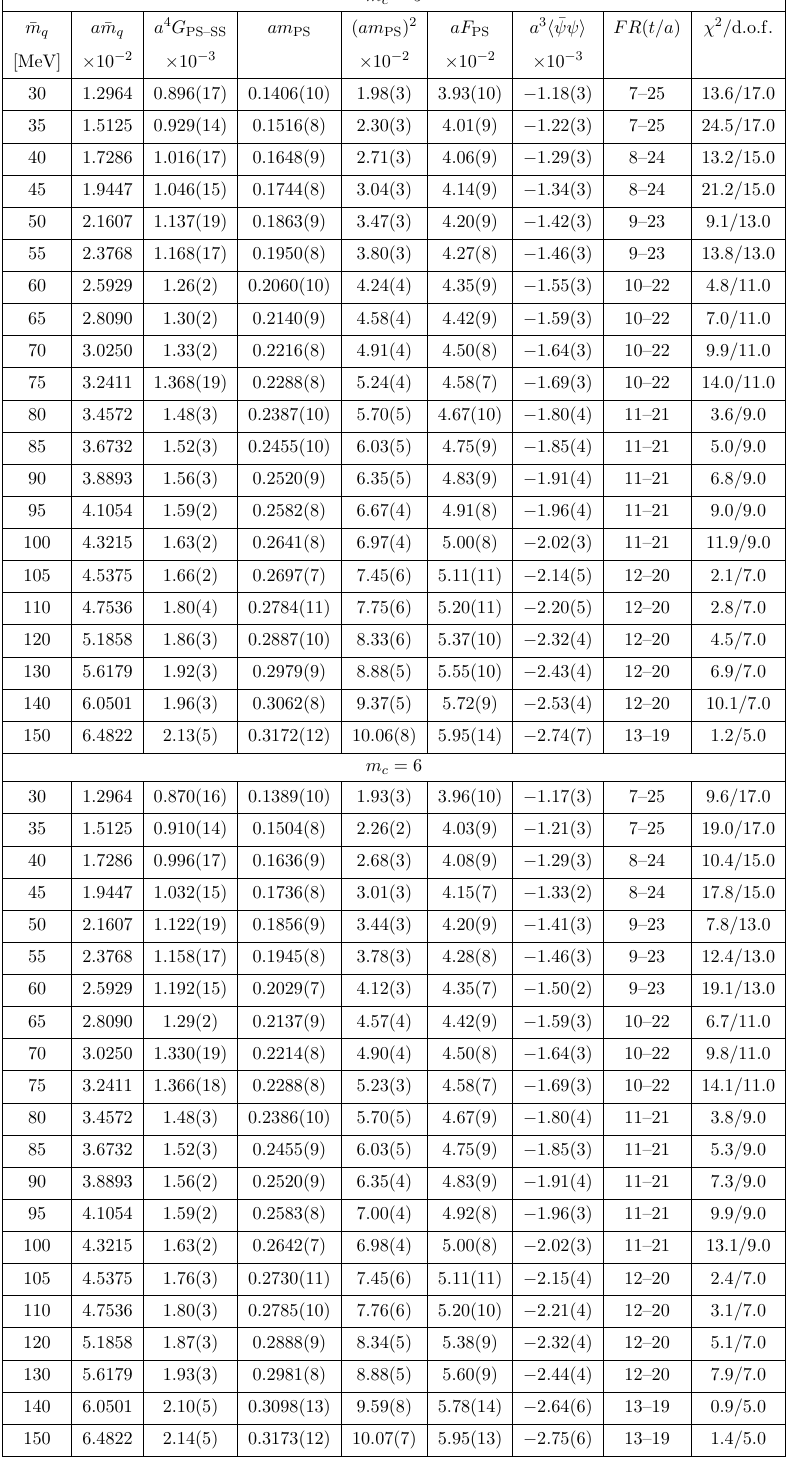
Table 27 . The (cid:12)tting results of a 4 G PS{SS and am PS together with the analytic results of the square of the pseudoscalar mass ( am PS ) 2 , decay constant aF PS Y , and chiral condensate a 3 h (cid:22) i . The magnetic charges of the con(cid:12)gurations are m c = 5 and m c = 6.